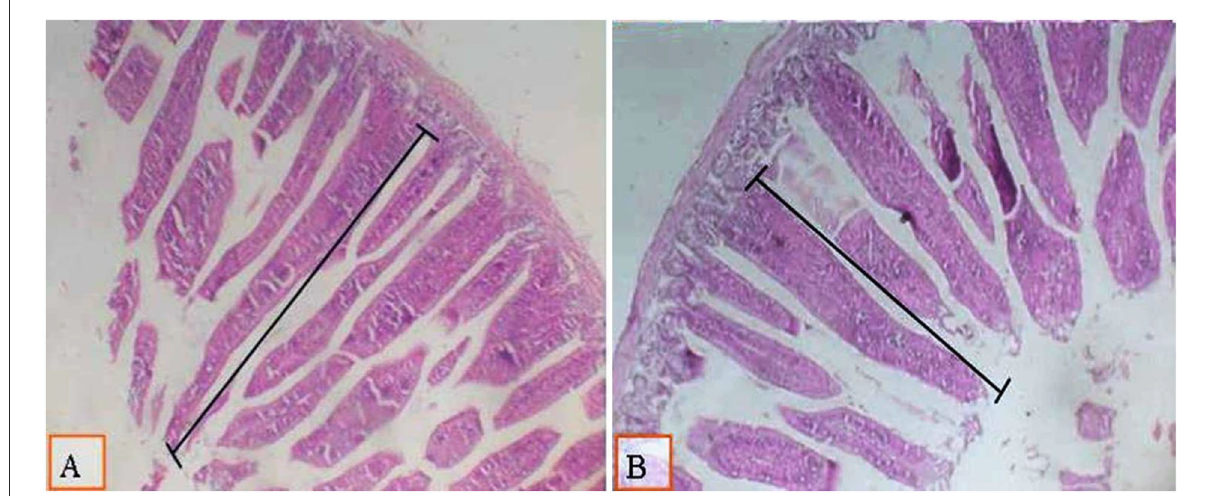
FIGURE2 Micrograph of broiler intestines at 38 d of age using H and E staining (X40) and measured from the base to the apex to investigate the villous length in various experimental groups: (A) the group of broilers fed on a low-density diet with 0.1% of multi-enzymes; (B) the group of broilers fed on the same diet with 0.2% of multi-enzymes. A significant enhancement of villous length was observed in broilers fed on dietary feeds with 0.2% of multi-enzyme supplementation (A)